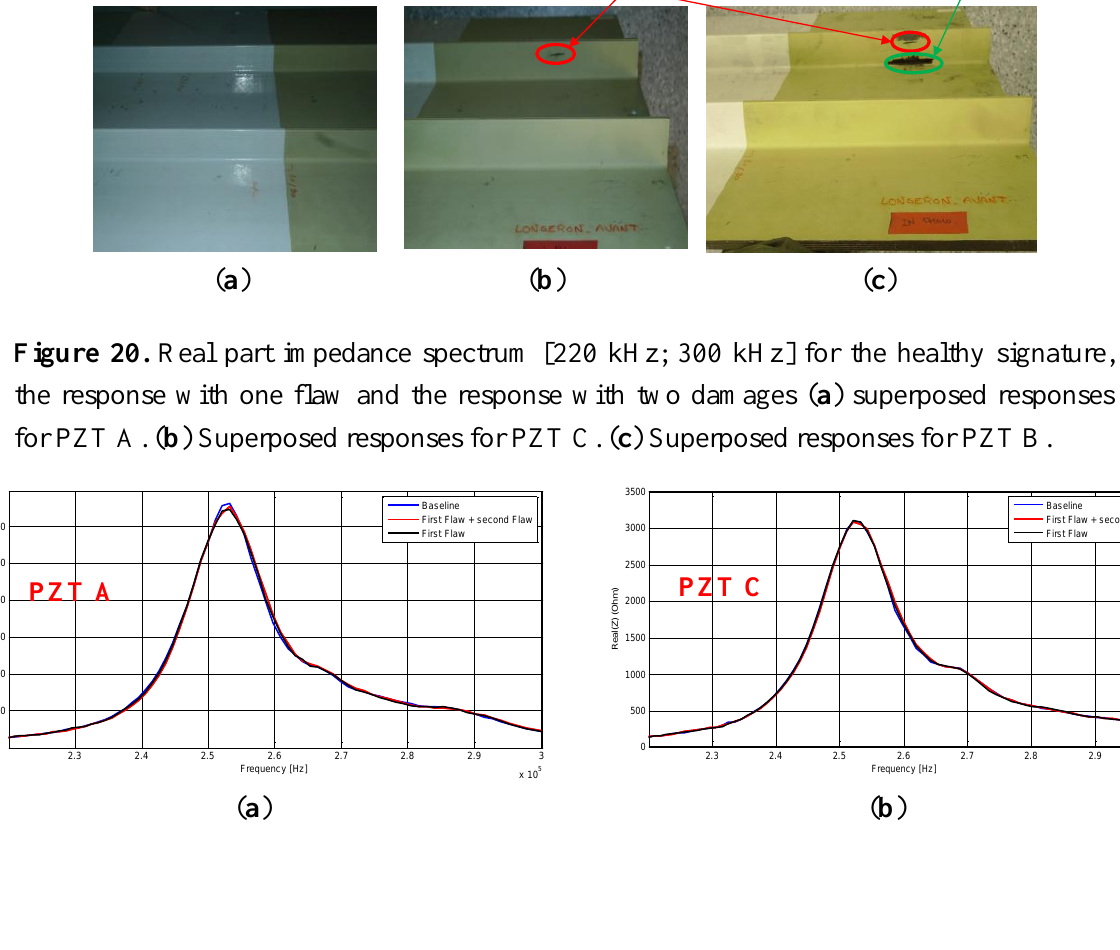
Figure 19. ( a ) Healthy wing front spar. ( b ) The same structure with one introduced crack into the second stiffener. ( c ) The same stiffener with a second introduced crack. Flaw 1 Flaw 2 Healthy